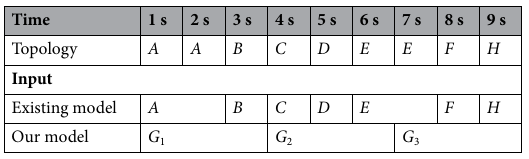
Table 1. The input of different temporal prediction